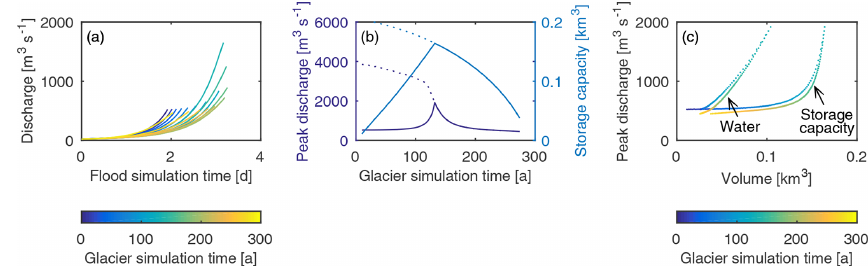
Figure 8. Comparison of annual outburst floods for the box-shaped basin in which the basin is connected to the subglacial hydrological system as it fills. (a) Annual outburst flood hydrographs. (b) Peak discharge and basin storage capacity for ice-filled and ice-free basins. The fork in the early years of the simulations represents ice-filled (solid line) and ice-free (dotted line) scenarios. (c) Relationship between peak discharge and peak water volume (“Water”) and basin storage capacity (“Storage capacity”).